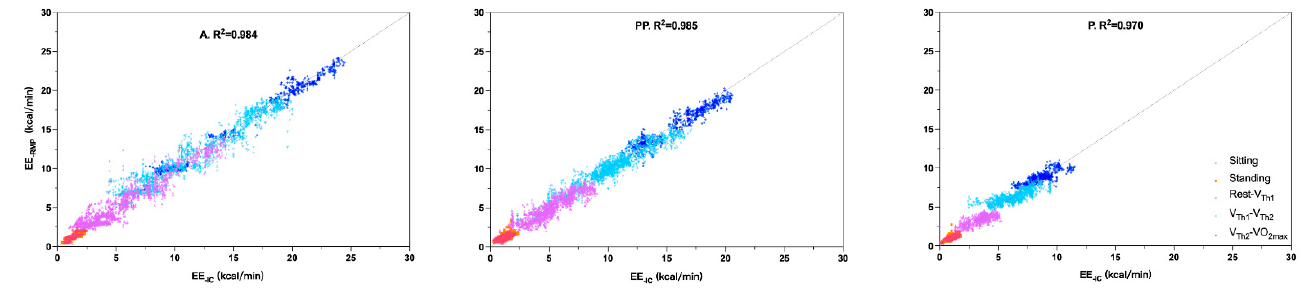
Figure 6. Estimated (EE -RMP ) and measured (EE -IC ) energy expenditure individual values for each group. A: adult; PP: post-pubertal; P: pubertal; EE -IC : energy expenditure measured from indirect calorimetry; EE -RMP : energy expenditure estimated from respiratory magnetometer plethysmogra-